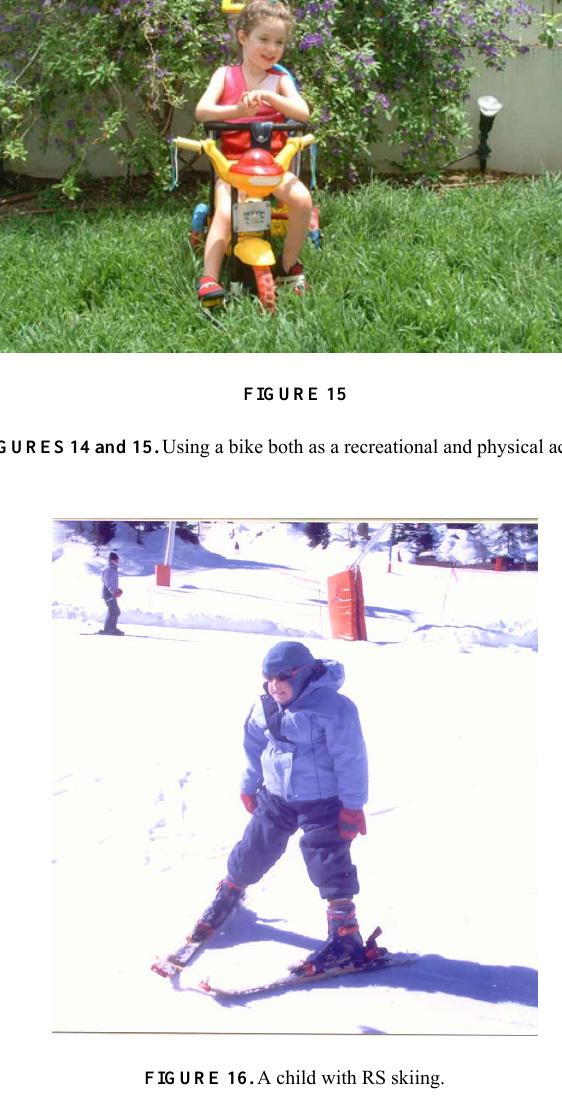
FIGURE 16. A child with RS